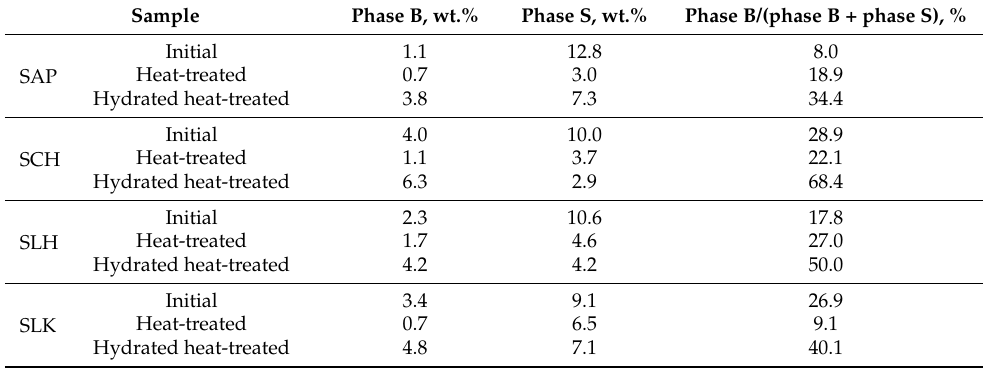
Table 5. Thermogravimetry analysis results of serpentine samples.